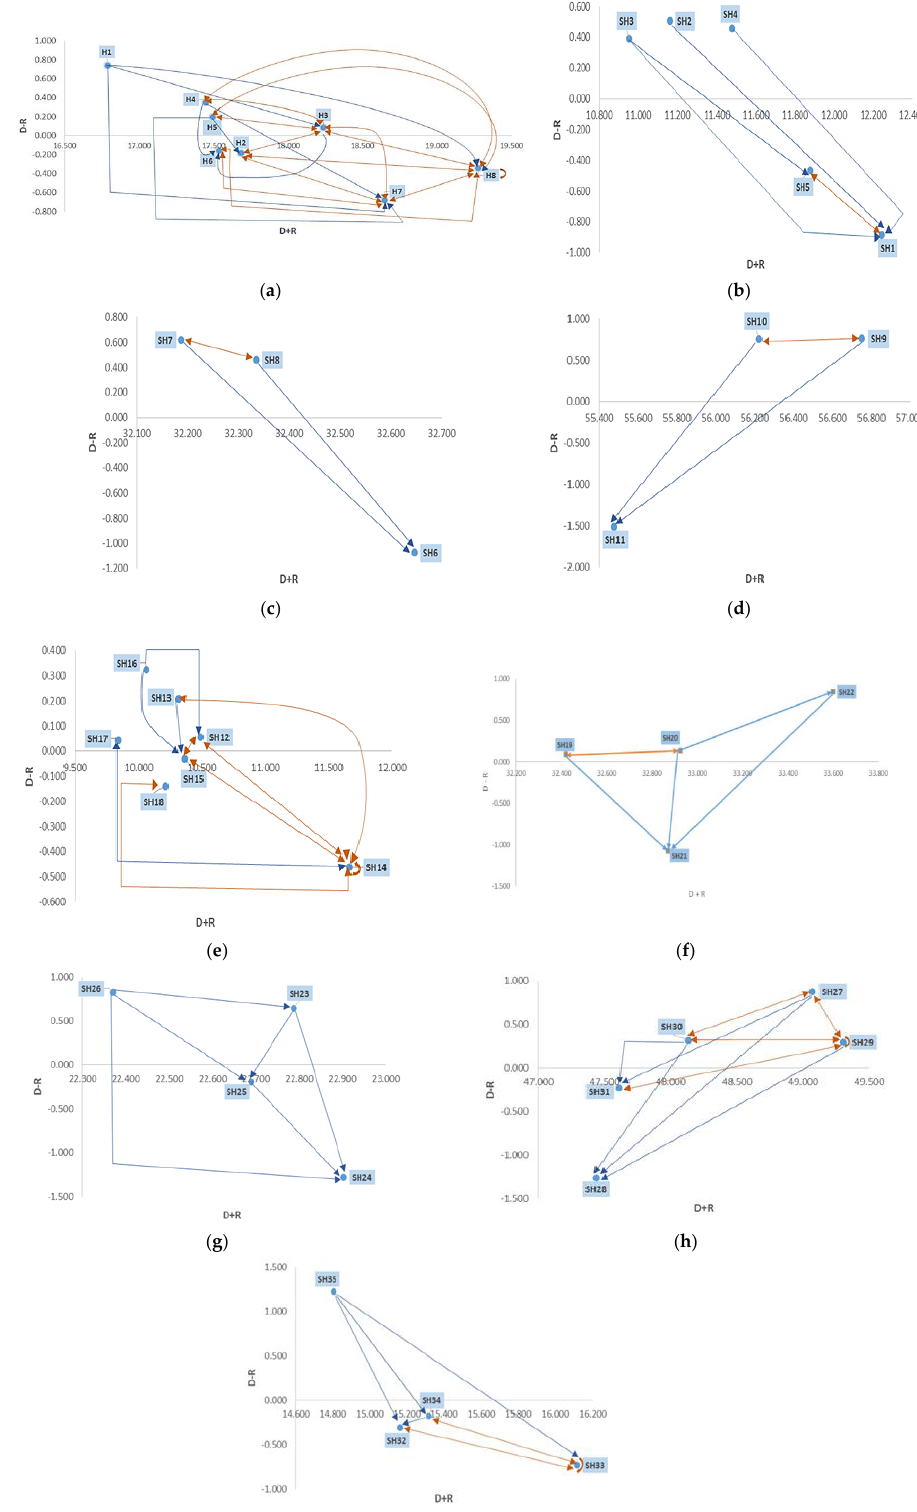
Figure 6. Influential-relation map for ( a ) criteria, ( b ) ER facilities, ( c ) healthcare equipment, ( d ) procedures and protocols ( e ) assisting processes, ( f ) human talent, ( g ) supply of medicines and medical accessories, ( h ) quality in healthcare, and ( i ) patient safety.